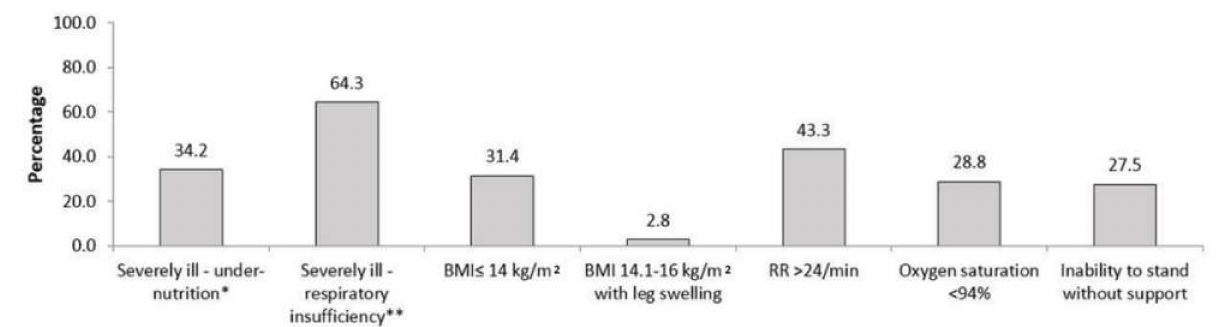
Figure 2. Contribution ($) of individual indicators to ‘high risk of severe illness’ at notification among adults ( ≥ 15 years) with TB (without known drug-resistant disease at diagnosis) from public health facilities of 16 districts in Karnataka, India, 15 October to 30 November 2020 (n = 538) (@) . * Presence of any one indicator–BMI ≤ 14 kg/m 2 , BMI ≤ 14.1–16 kg/m 2 with leg swelling; ** Presence of any one indicator–respiratory rate > 24/min, oxygen saturation < 94%;